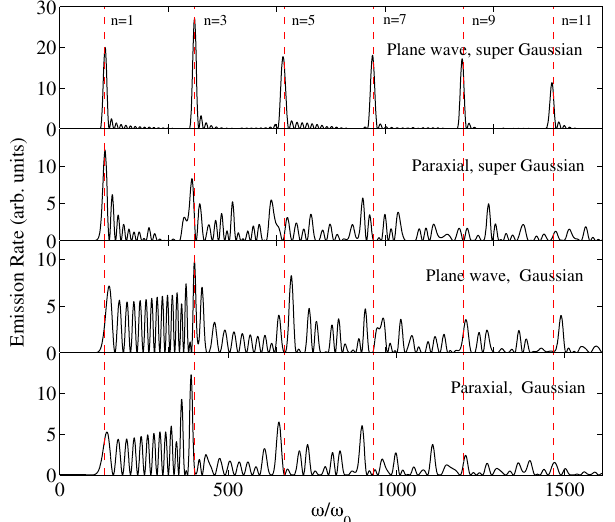
π for an FIG. 4. Thomson emission spectra calculated at θ obs ¼ electron of initial γ 0 ¼ 10 counterpropagating along the laser axis. In all cases the laser pulse has a peak a 0 ¼ 2 and is 10 cycles in duration (27 fs). It is either a plane wave or paraxial field [focussed to θ 0 ¼ 1 = π ( w 0 ¼ λ )], with a Gaussian or super Gaussian envelope, as indicated in the panels. The red (dashed) lines show the positions of the odd-numbered harmonics calcu- lated for the case of a monochromatic plane wave. the plot. It can be seen in the top panel that, as expected, the plane wave field with a super Gaussian envelope is a good approximation to the infinite plane wave field, with all the harmonics lining up in the correct positions and being very narrow, almost δ function, spikes. If we retain the super Gaussian envelope but switch to a focussed paraxial beam ( w 0 ¼ λ , θ 0 ¼ 1 = π ≈ 0 . 32 ), the harmonics begin to spread